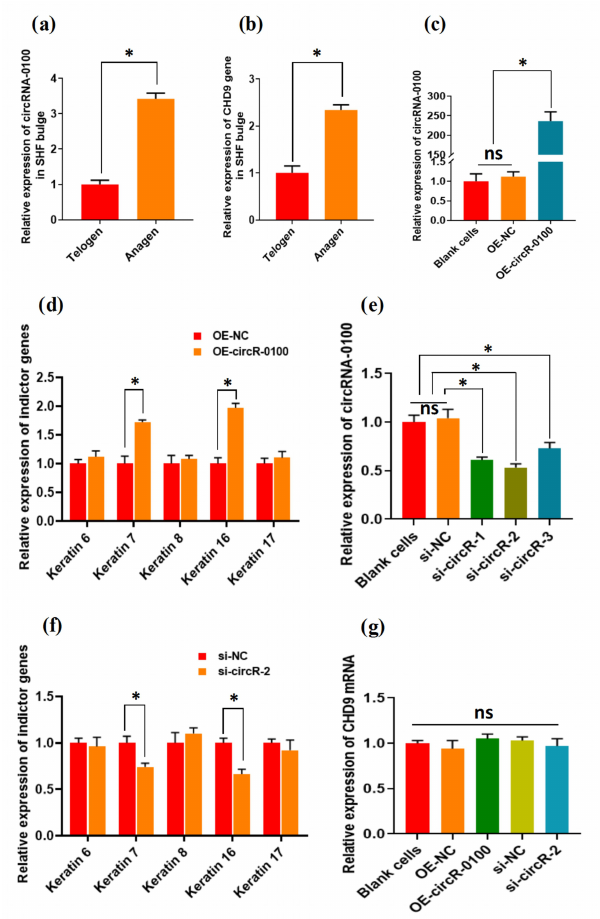
Figure 2. The expression patterns of circRNA-0100 along with its host gene CHD9 in the SHF bugle of cashmere goats and the ef- fects circRNA-0100 on the differentiation of SHF-SCs into hair fol- licle lineages of cashmere goats. (a) Expression pattern of circRNA- 0100 in the SHF bugle of cashmere goats. (b) Expression pattern of the host gene CHD9 of circRNA-0100 in the SHF bugle of cashmere goats. (c) Overexpression efficiency analysis of circRNA-0100 in SHF-SCs of cashmere goats. (d) Overexpression of circRNA-0100 caused the significant increase in indictor genes: Keratin 7 and Ker- atin 16 in SHF-SCs of cashmere goats. (e) Knockdown efficiency analysis of si-circR-1, si-circR-2, and si-circR-3 to circRNA-0100 in SHF-SCs of cashmere goats. (f) Knockdown of circRNA-0100 caused the significant decrease in indictor genes: Keratin 7 and Ker- atin 16 in SHF-SCs of cashmere goats. (g) Neither overexpression nor knockdown of circRNA-0100 had a significant effect on the ex- pression of its host gene CHD9 in SHF-SCs of cashmere